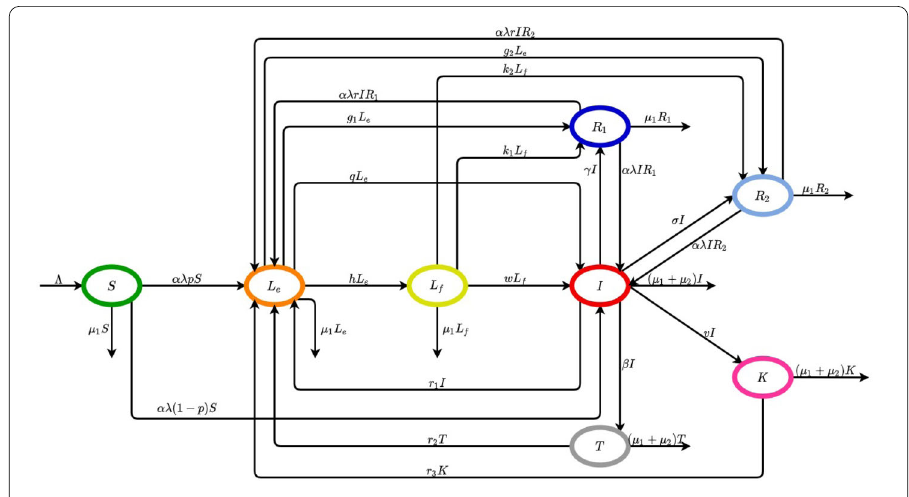
Figure 1 Diagram describing the dynamics between compartments for TB